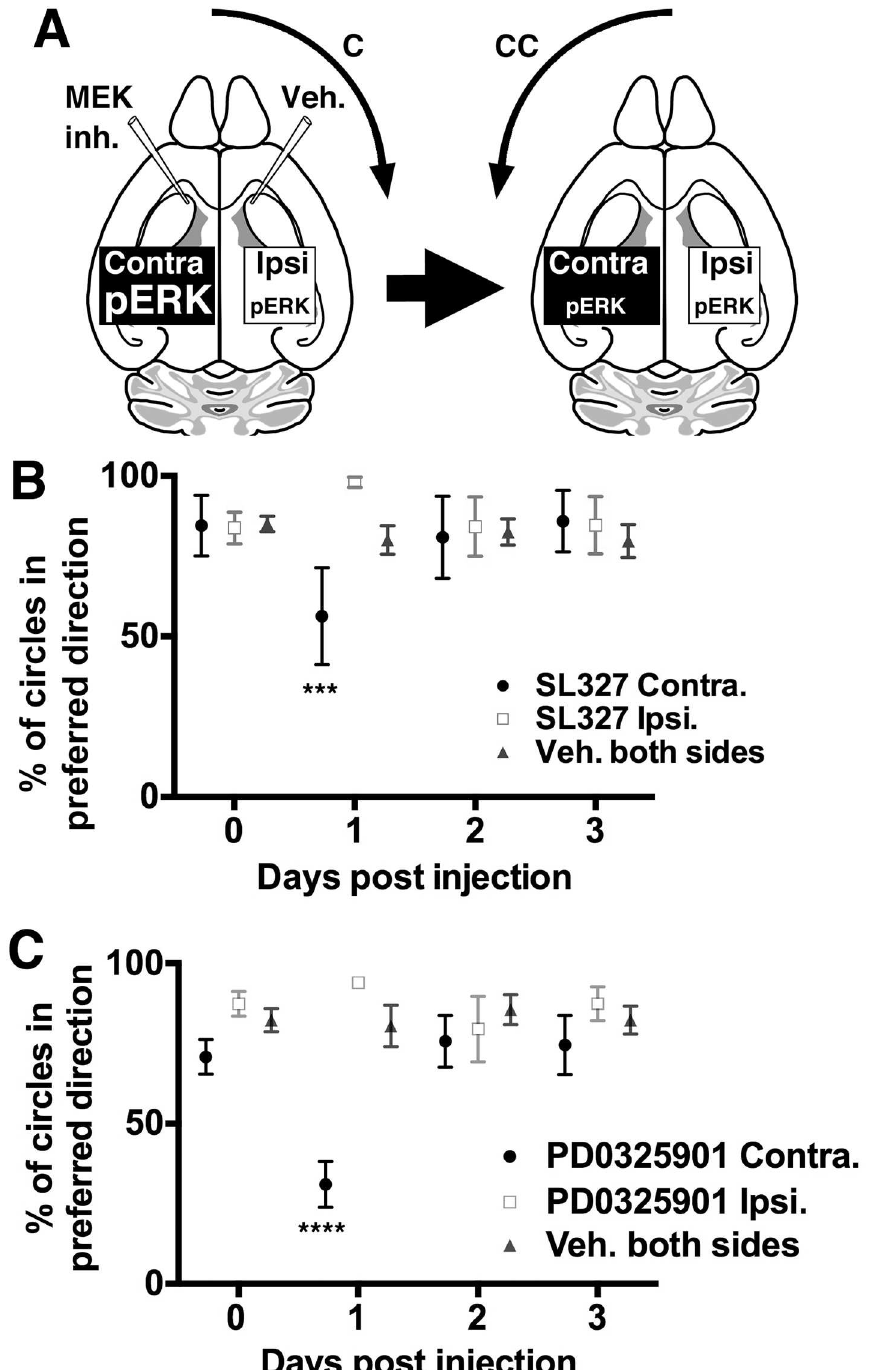
Fig 5. Signaling mediated through striatal ERK contributes to lateralization. (A) Illustration of the hypothesized dependence of the preferred turning direction on asymmetric striatal p-ERK levels and how SL327 inhibition could reduce or reverse the directional preference; C, CC. (B) SLC327-inhibition of p-ERK in the contralateral ventral striatum and vehicle in the ipsilateral side of Slc12a2 K842 (cid:3) /K842 (cid:3) mutants reduces clockwise circling 1 day post injection ( n = 4; p = 0.0007 with two-tailed Chi-square and Fisher exact tests), while bilateral vehicle has no effect ( n = 7). SL327 injected ipsilaterally trended toward increasing the already high clockwise circling 1 day post injection ( n = 7). Repeated measures ANOVA with the Tukey multiple comparison test; mean ± SEM. See also S1 Data. (C) PD0325901 inhibition of p-ERK in the contralateral ventral striatum and vehicle in the ipsilateral side of Slc12a2 K842 (cid:3) /K842 (cid:3) mutants also reduces clockwise circling 1 day post injection ( n = 8; p < 0.0001 with two-tailed Chi-square and Fisher